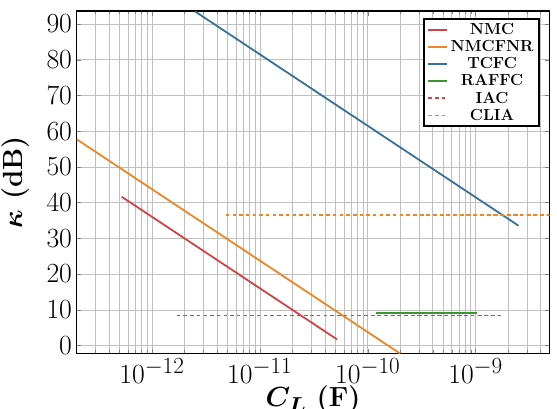
Figure 15. The value of κ estimated from simulation results as a function of load capacitance for each